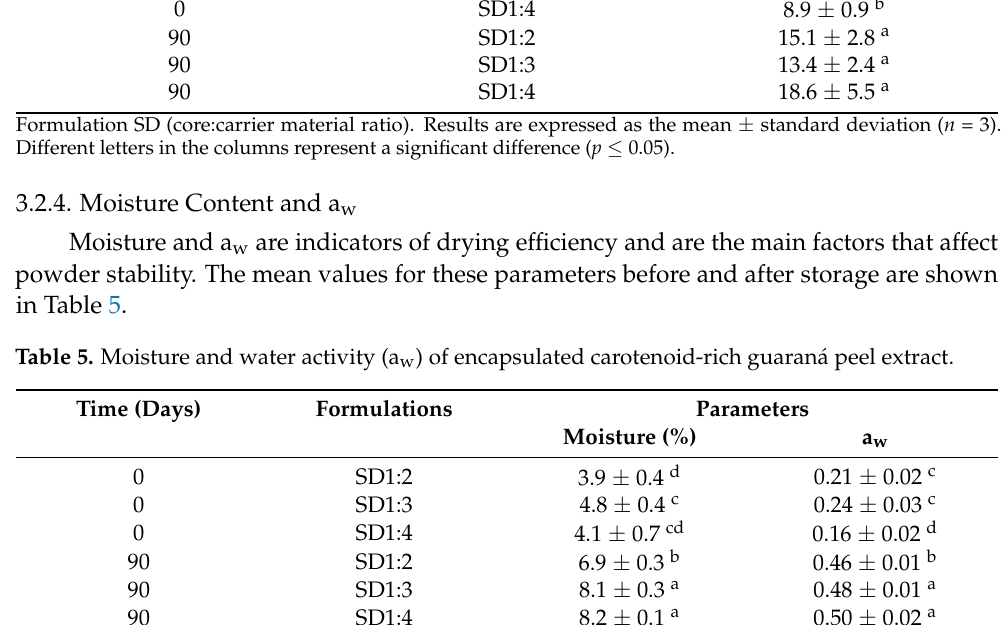
Table 4. Mean and standard deviation of median diameter sizes ( µ m) expressed in volume for each formulation of microparticles obtained by spray drying at 0 and 90 days of storage at 25 ◦ C. Time (days) Formulations Median Diameter ( µ m) 0 SD1:2 11.9 ± 1.5 a 0 SD1:3 9.1 ± 1.8 ab 0 SD1:4 8.9 ± 0.9 b 90 SD1:2 15.1 ± 2.8 a 90 SD1:3 13.4 ± 2.4 a 90 SD1:4